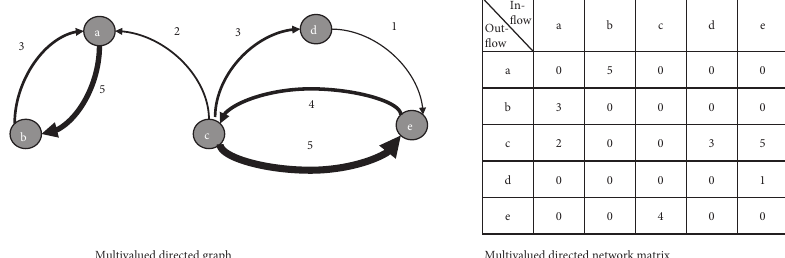
Figure 1: Multivalued network graph and multivalued network